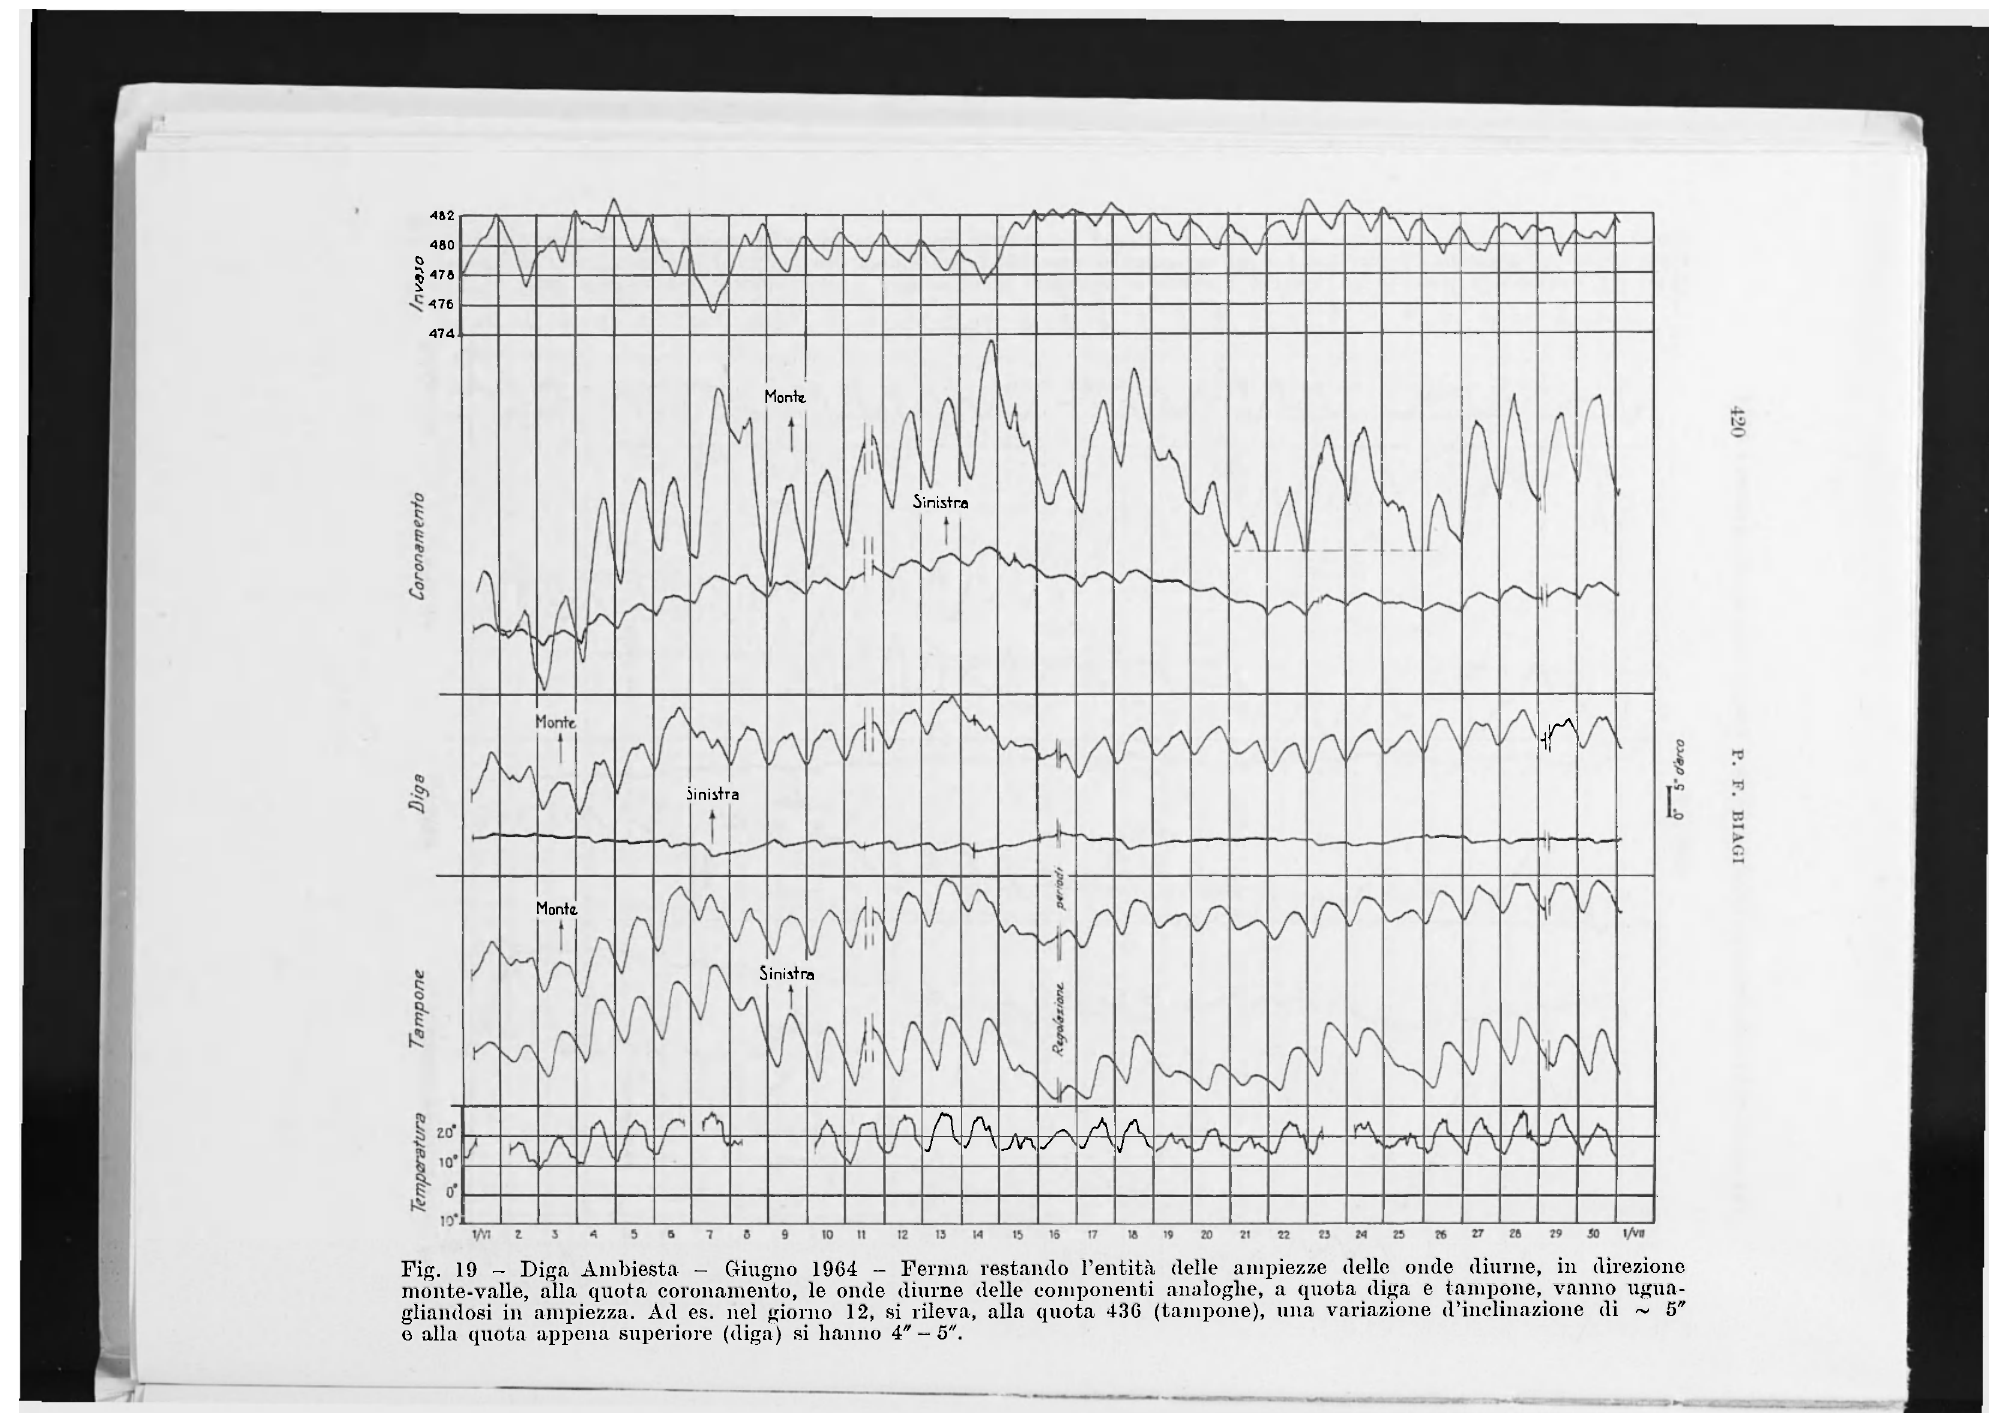
Fig. 19 - Diga Ambiesta - Giugno 1964 - Ferma restando l'entità delle ampiezze delle onde diurne, in direzione monte-valle, alla quota coronamento, le onde diurne delle componenti analoghe, a quota diga e tampone, vanno ugua- gliandosi in ampiezza. Ad es. nel giorno 12, si rileva, alla quota 436 (tampone), una variazione d'inclinazione di ~ 5" e alla quota appena superiore (diga) si hanno 4" - 5".